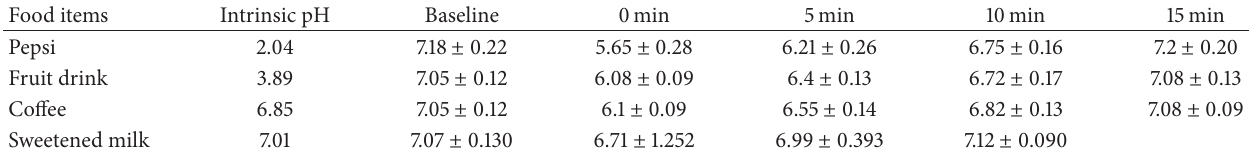
Table 1: Intrinsic pH and mean salivary pH at different intervals of time after consumption of different liquid food items. Food items Fruit drink